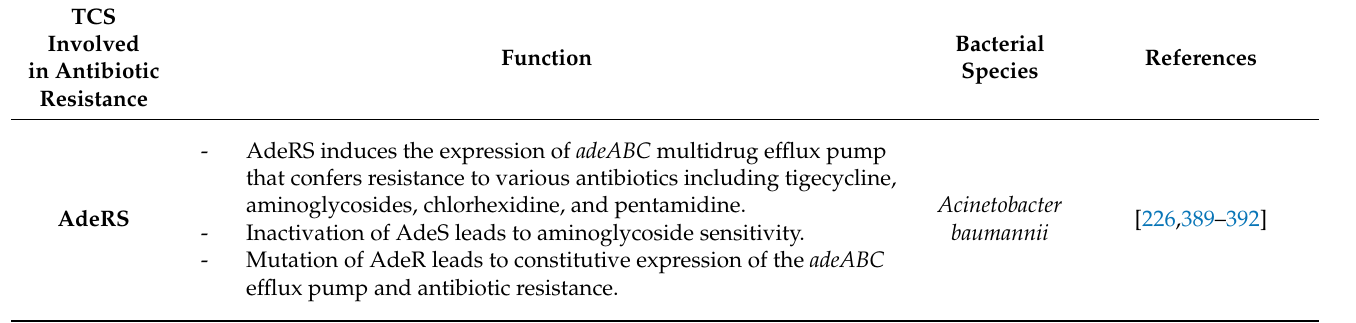
Table 2. Examples of two-component systems (TCSs) involved in antibiotic